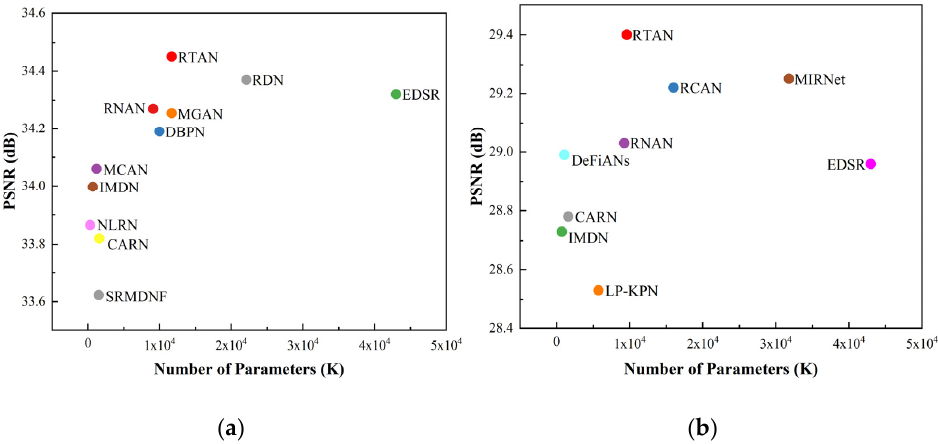
Figure 7. The performance and number of parameters. The results are evaluated on four standard benchmark datasets (Set5, Set14, BSD100, Urban100) and two real-world test datasets (Canon, Nikon). ( a ) Results on BI degradation model (×2), ( b ) Results on real-world degradation model (×4).